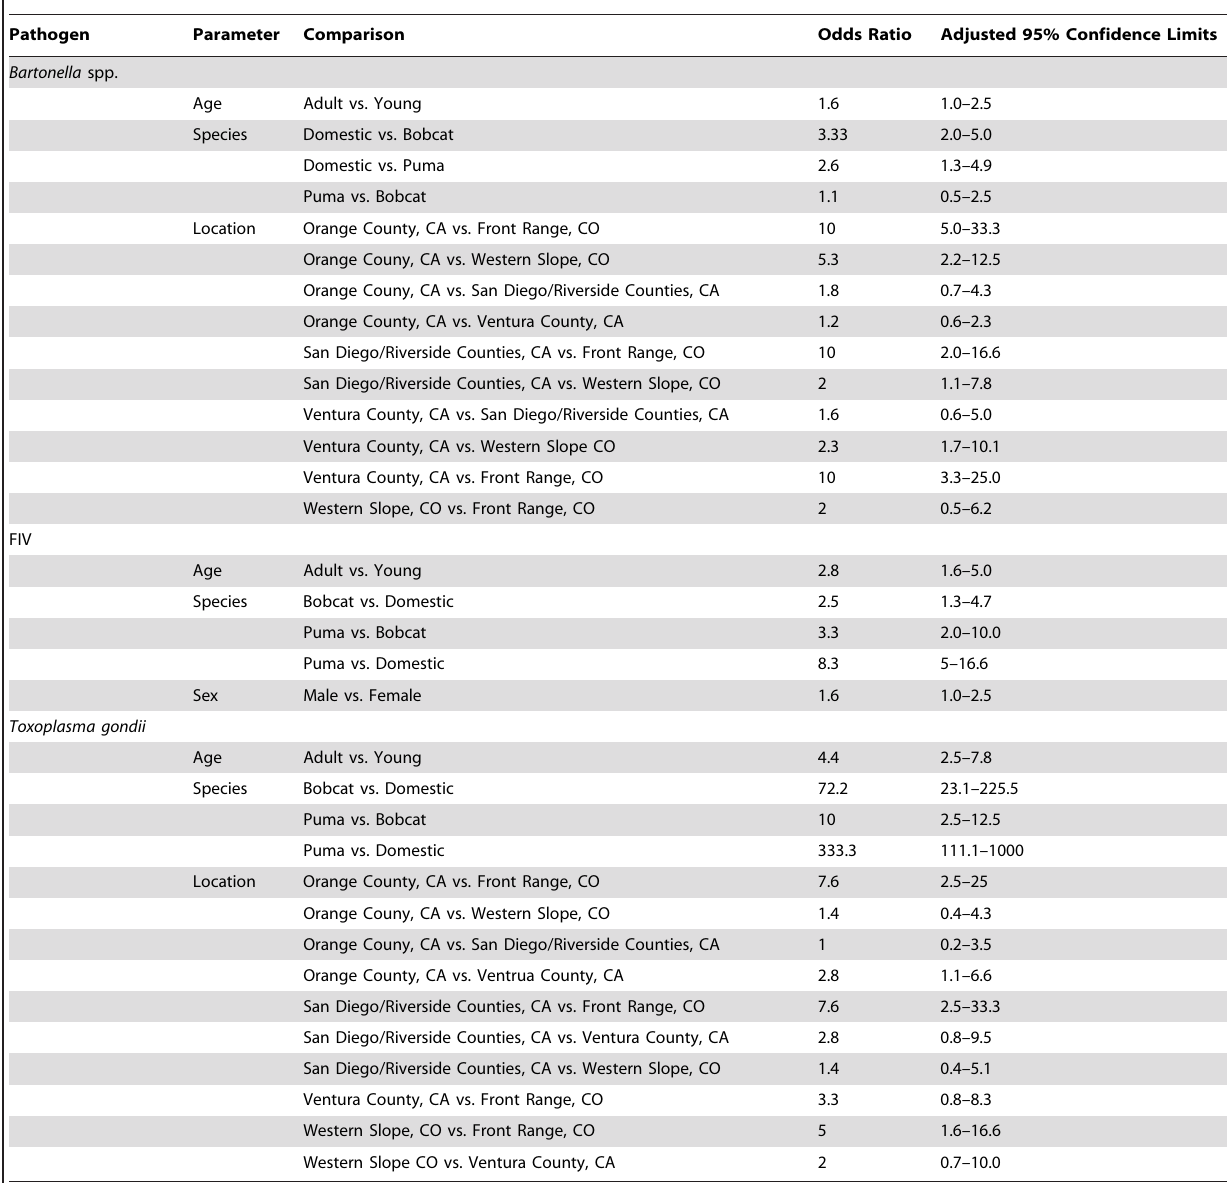
Table 3. Odds ratios and adjusted 95% confidence limits for parameters from best supported models.